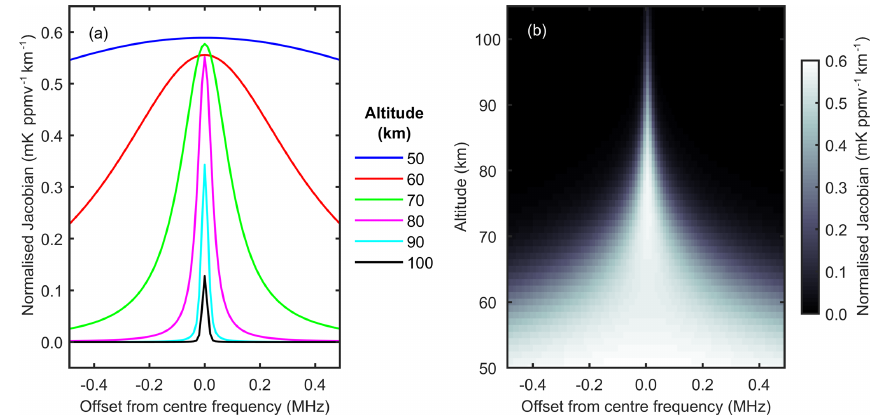
Figure 10. Rows of the Jacobian describing the ozone (O 3 ) retrieval, normalised by the layer thickness of the retrieval grid. The data are for retrievals from simulated 6h observations of the O 3 11.072GHz emission line using a ground-based radiometer with 1mK baseline noise level, 10kHz frequency resolution, and an 82 ◦ zenith angle located at Kilpisjärvi (69 ◦ 03 (cid:48) N, 20 ◦ 48 (cid:48) E), Finland, in clear-sky December conditions. Rows of the Jacobian matrix for selected altitude levels are plotted in (a) . The grey scale in (b) indicates the values of the Jacobian